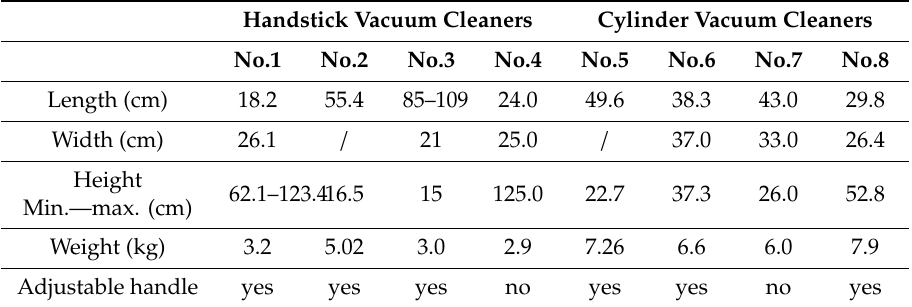
Figure 1. Eight di ff erent domestic vacuum cleaners (4 handstick and 4 cylinder vacuum cleaners) from four di ff erent manufacturers are shown in this figure. Table 1. Properties of the vacuum cleaners according to the manufacturers’